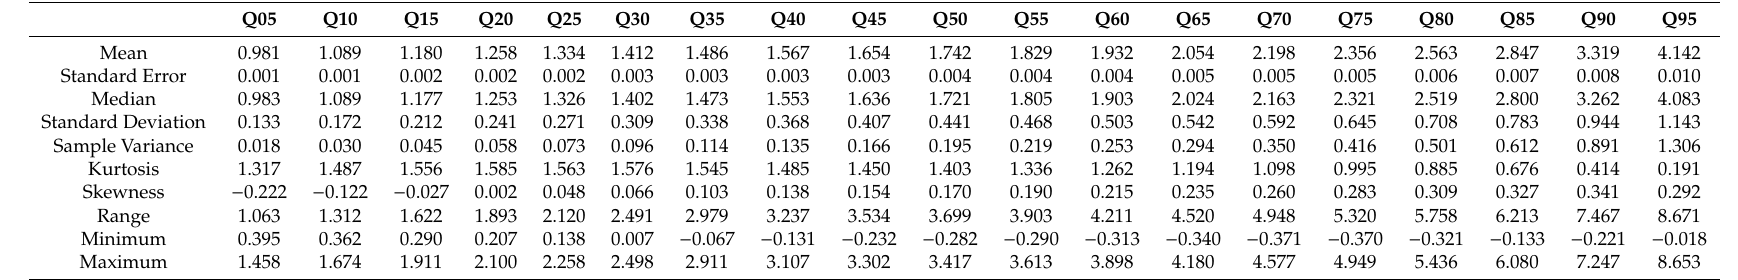
Table 4. Summary Statistics with Fitted values of Quantile